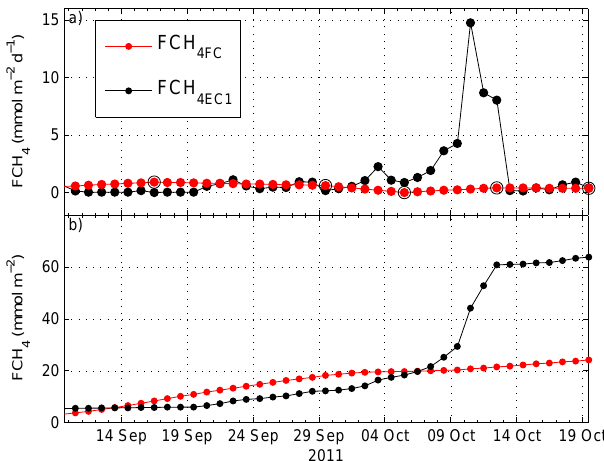
Figure 4. (a) Mean daily FCH 4EC1 , (black dots) and FCH 4FC (red dots), calculated from half hour mean values of half hour fluxes showed in Fig. 2b. Gaps in the measurements have been filled by linear interpolation between the nearest neighbour. The encircled red dots indicate the FCH 4FC measurement occasions. (a) Cumu- lative sum of the daily FCH 4EC1 , (black dots) and FCH 4FC , (red dots). Note that FCH 4FC estimates were not continuous but based on a limited number of 30min daytime measurements which seems to have coincided with relatively low flux estimates from EC1. Con- tinuous 24h flux chamber measurements covering also the periods with high EC fluxes might therefore have resulted in better agree- ment than indicated by (b) .